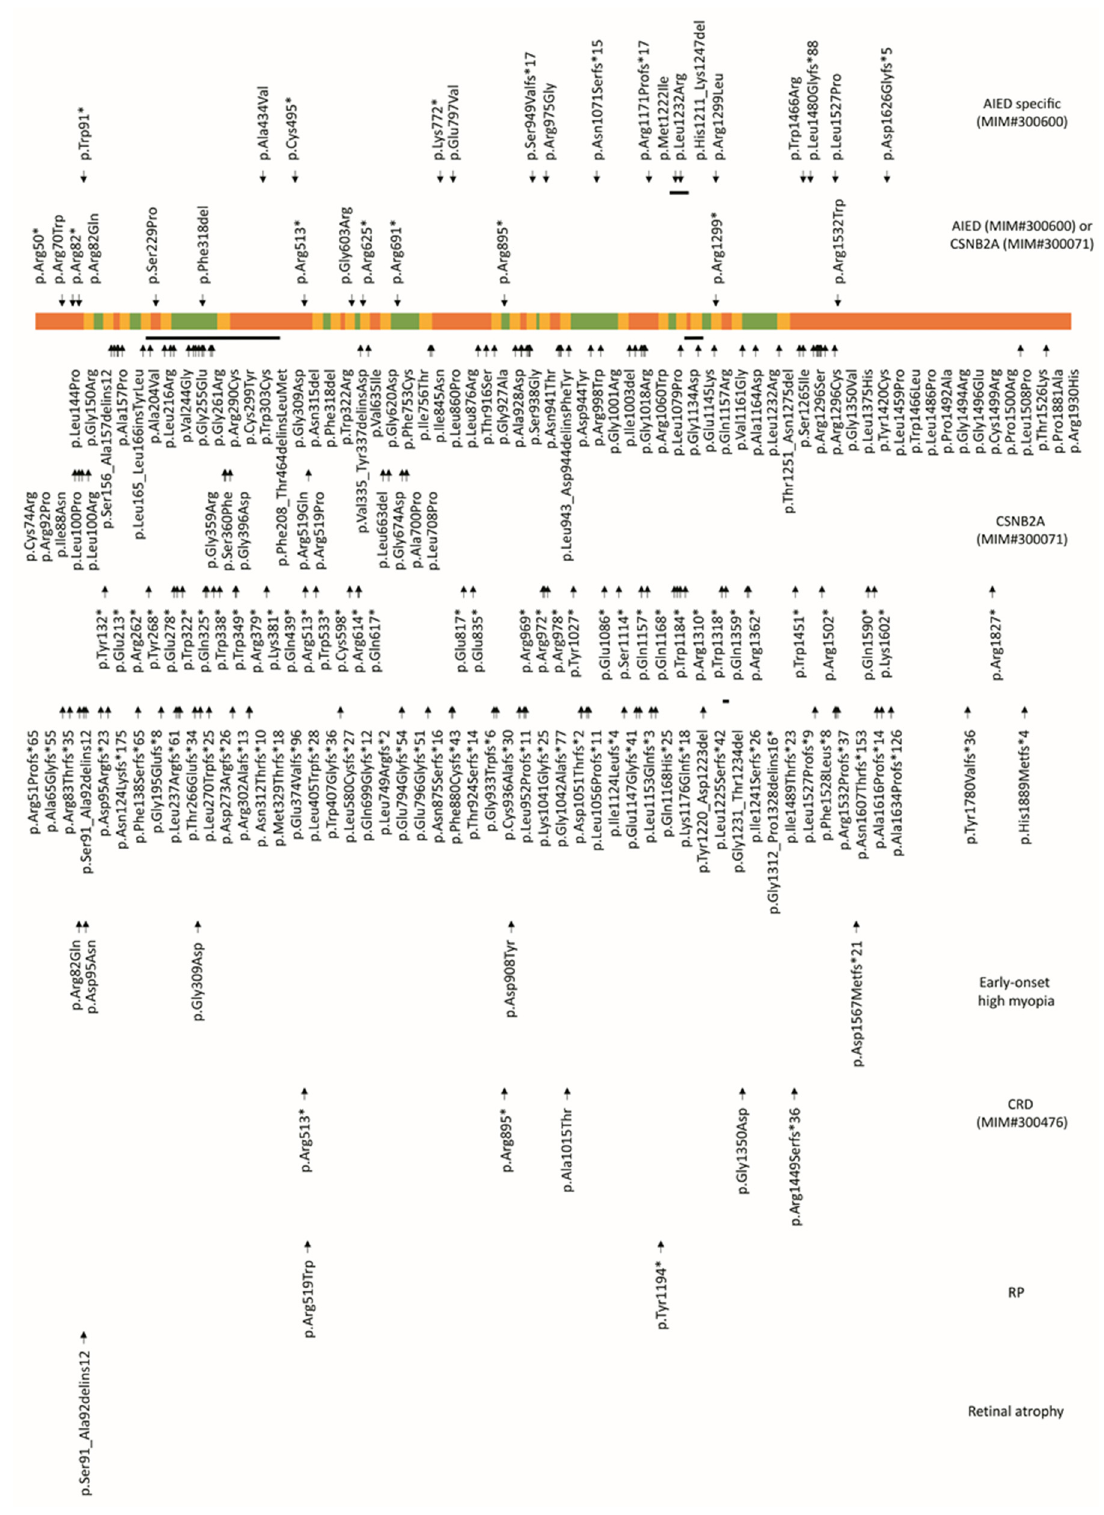
Figure 5. CACNA1F disease-causing variants are associated with ocular disorders. CACNA1F protein is composed of several cytoplasmic (orange), helical (yellow), and extracellular (green) regions (NP_005174.2; Uniprot O60840). Abbreviations: AIED—Åland island eye disease, CSNB2A—congenital stationary night blindness, CRD—cone-rod dystrophy, RP—retinitis pigmentosa.